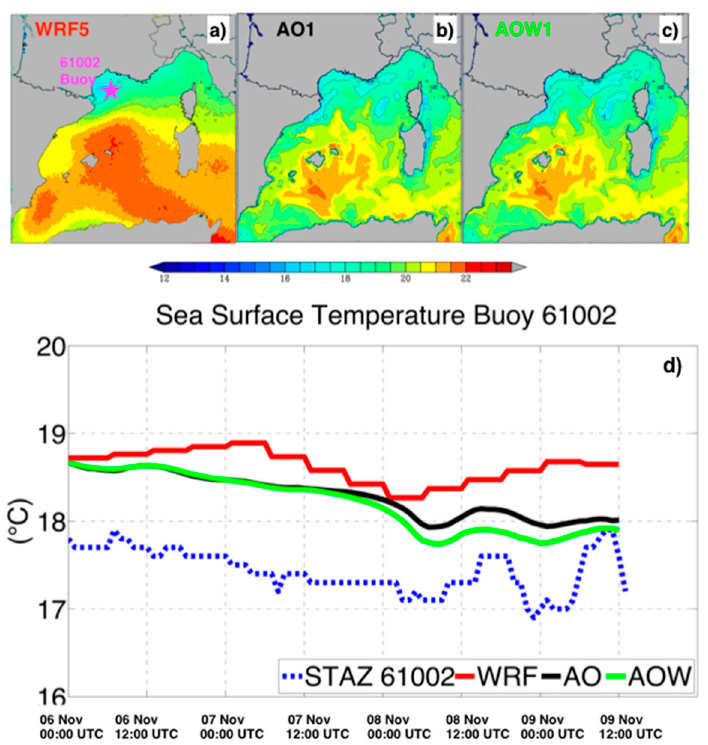
Figure 11. SST fields for the day 9 November 2011 at 12 UTC, for run WRF5 ( a ), AO1 ( b ), AOW1 ( c ). In panel ( a ) the position of the buoy #61002 (Meteo France) is shown. From the time series (panel ( d )),